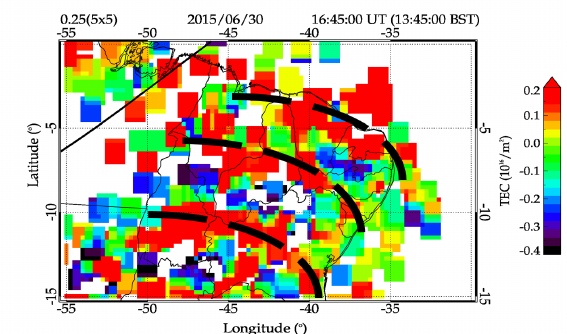
Figure 3. Detrending TEC (dTEC) maps with 1 min resolution over South America equatorial region 30 June 2014 at 16:45:00 UT (13:45:00 LT).